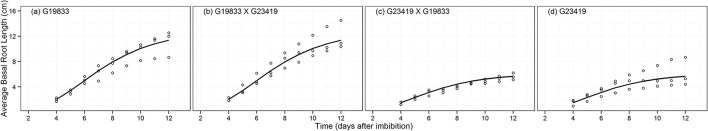
Fitted Gompertz growth function for the average basal root length (AvBRL, cm) data of parental genotype (A) G19833, the reciprocal F1 hybrids (B) (G19833 × G23419) and (C) (G23419 × G19833), and parental genotype (D) G23419.